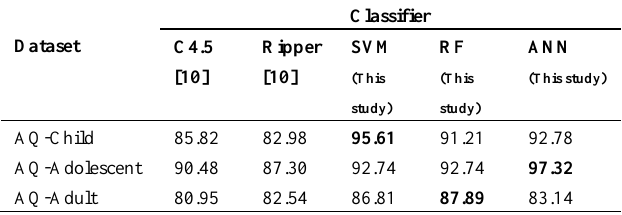
Table 5. The result of classifier sensitivity